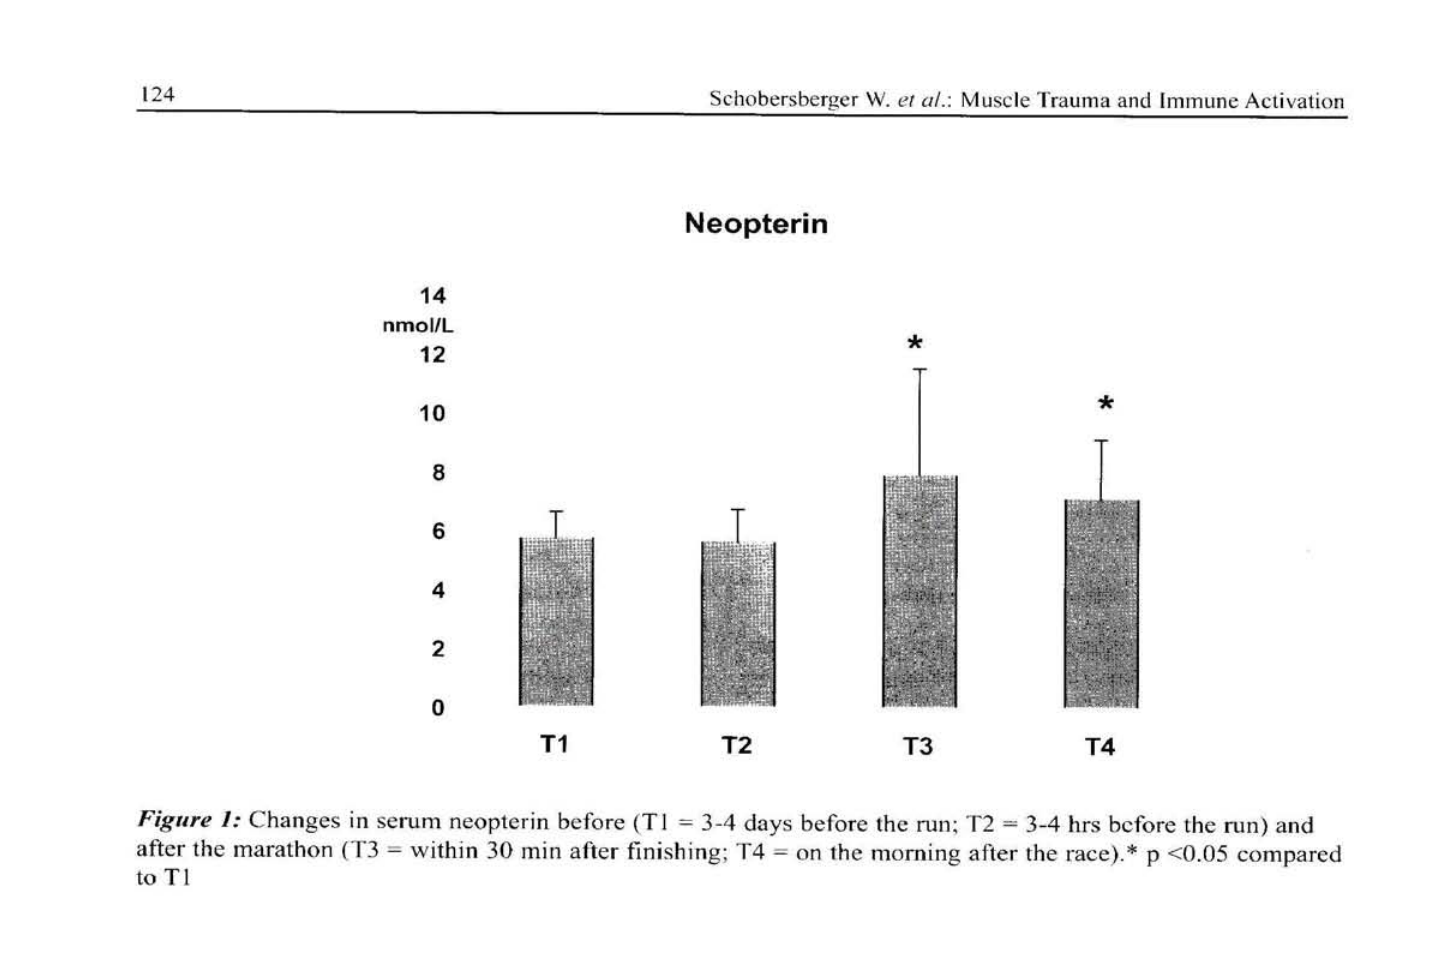
Figure 1: Changes in serum neopterin before (T1 = 3-4 days before the ran; T2 = 3-4 hrs before the run) and after the marathon (T3 = within 30 min after finishing; T4 = on the morning after the race).* ρ <0.05 compared